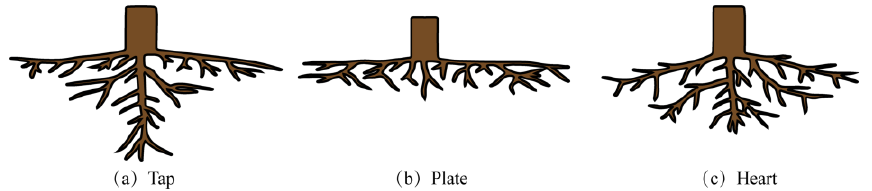
Figure 2. Schematic representation of root system morphologies. ( a ) tap-like root system, ( b ) plate-like root system, ( c ) heart-like root system.